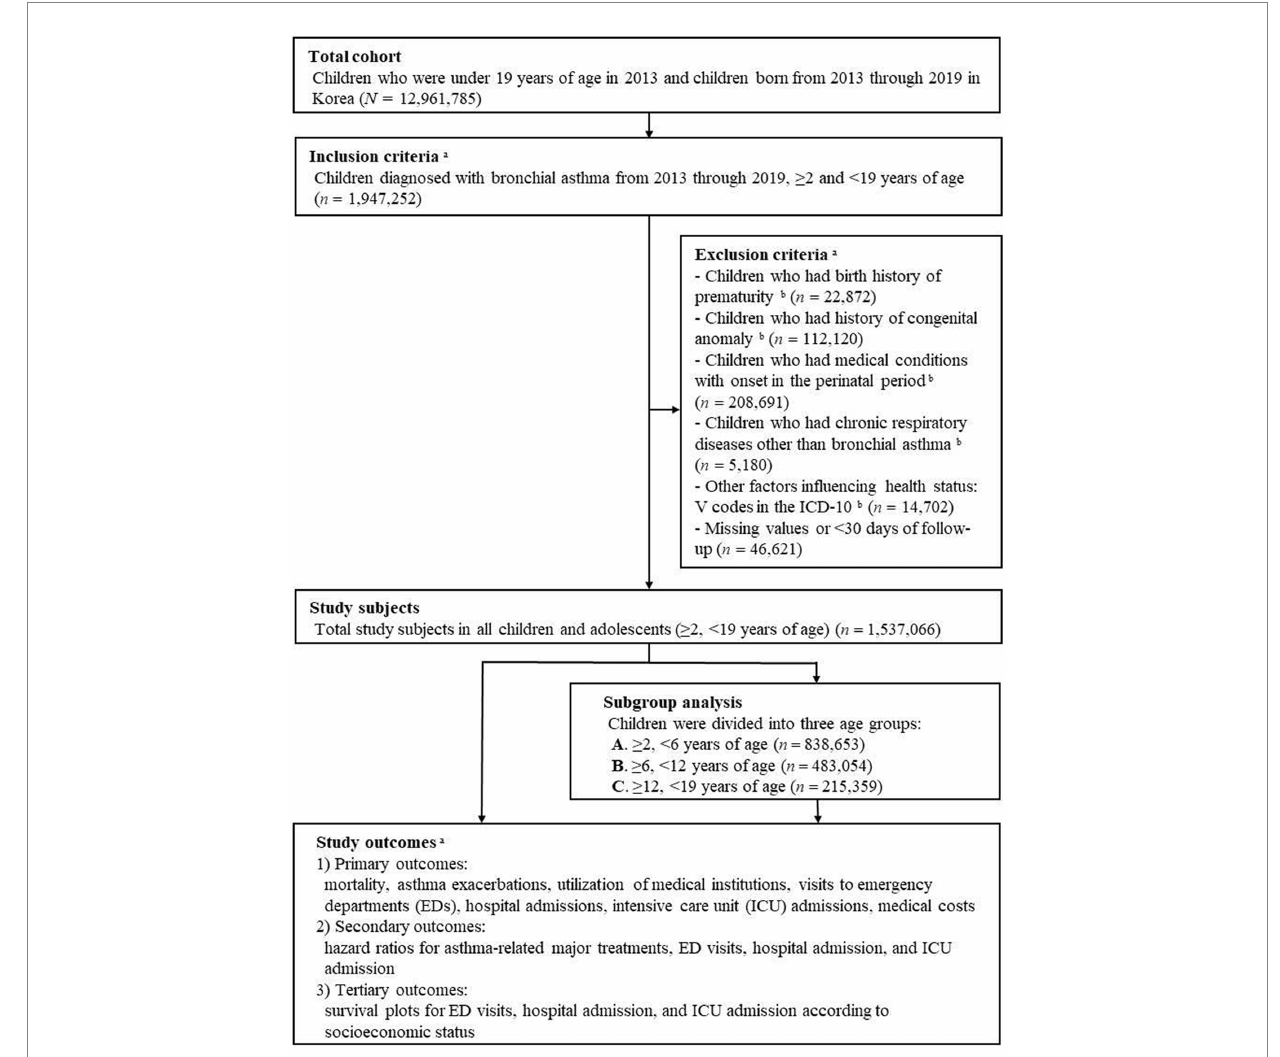
FIGURE 1 Flow diagram of the cohort, inclusions, exclusions, and outcomes. a Obtained from the Korean National Health Insurance Service (NHIS), b Diagnosis and conditions in children were identified by ICD-10 codes (Supplementary Appendix